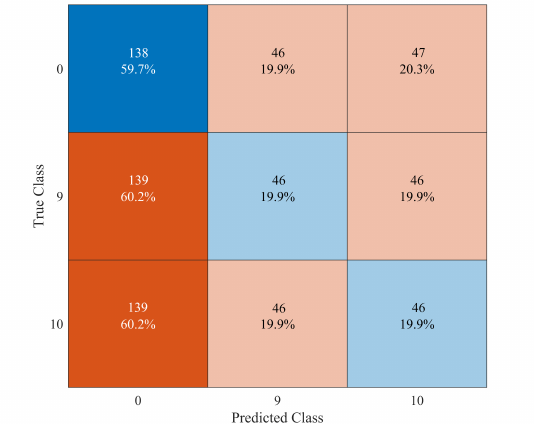
Figure 12. Confusion matrix for the 3-class recognition problem regarding the undamaged system (class “0”) and the failures of element “Elm 3823” (class “9” and